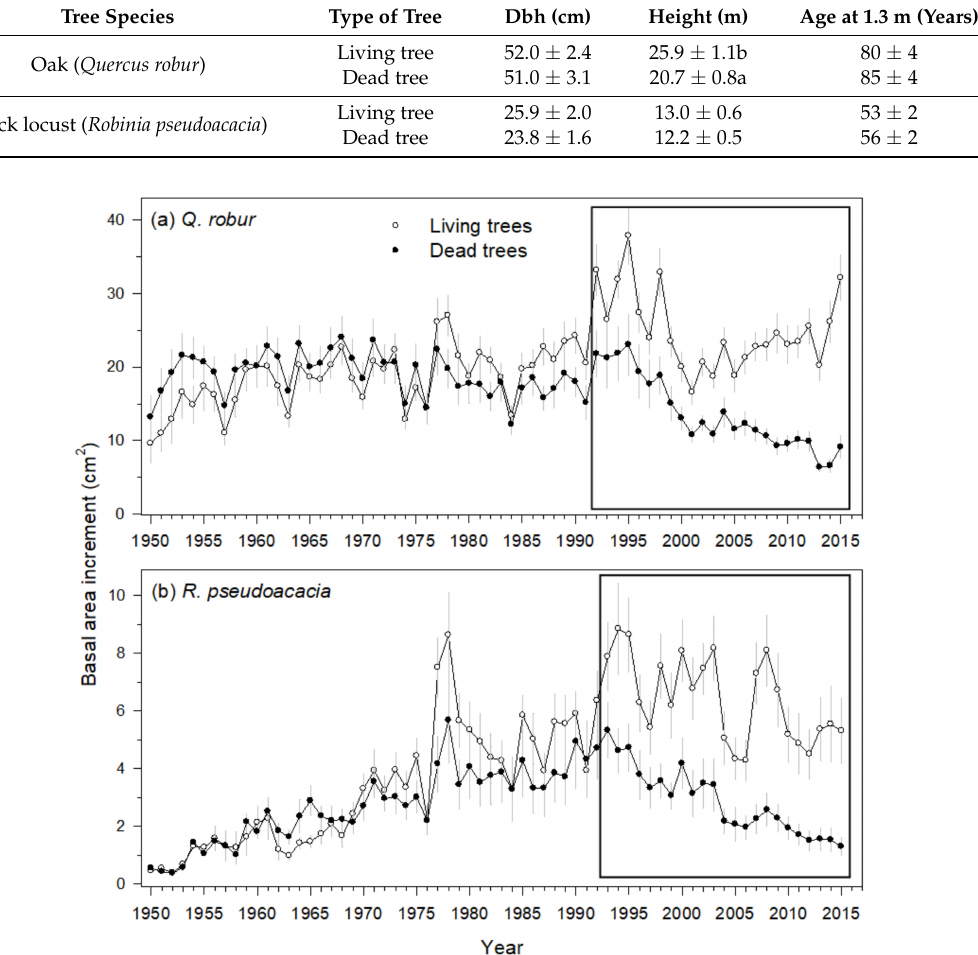
Figure 2. Patterns of basal area increment since 1950 of living (empty symbols) and dead (filled symbols) trees of ( a ) oak ( Quercus robur ) and ( b ) black locust ( Robinia pseudoacacia ). Values are means ± standard errors (SE). The boxes indicate the periods when basal area increment of living and recently dead trees significantly ( p < 0.05)